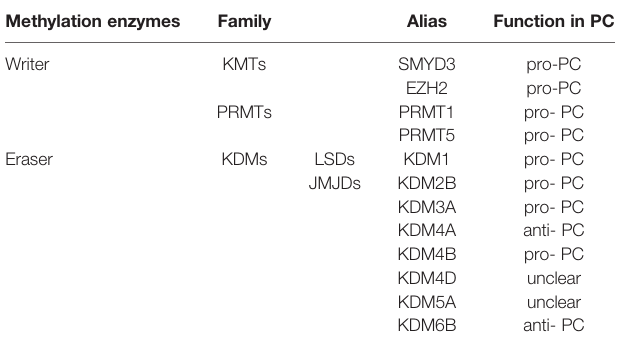
TABLE 2 | Major groups of histone methylation regulators in